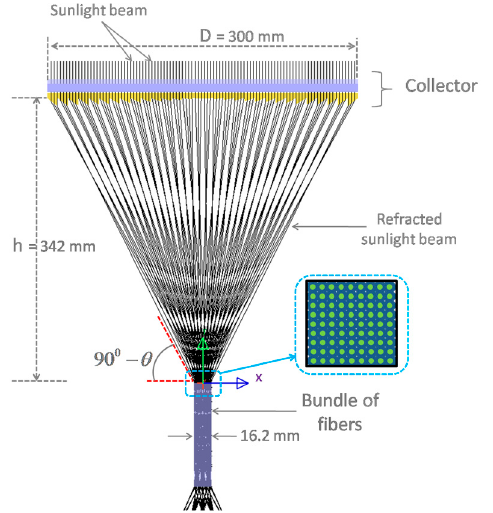
Figure 11. The ray tracing of collector and some parameters of the daylighting system. Table 1. The parameters of linear Fresnel lens for the collector.